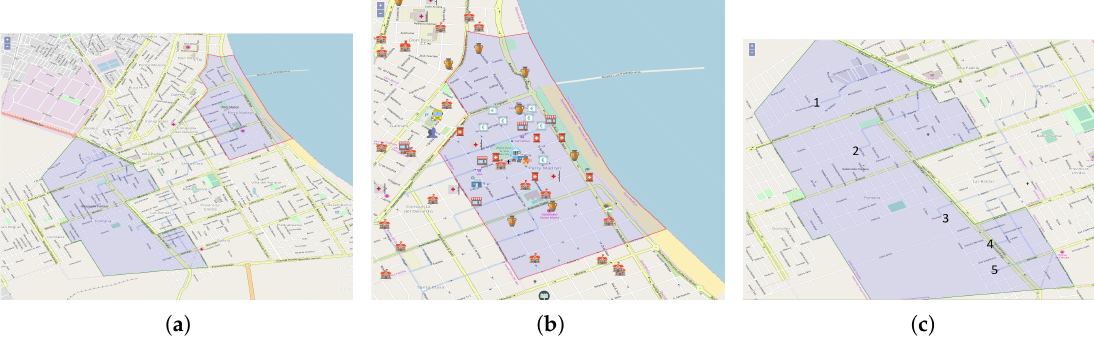
Figure 3. Visualization of generated trips. ( a ) Origin-Destination Zones; ( b ) Destination Centralities; ( c ) Origin of